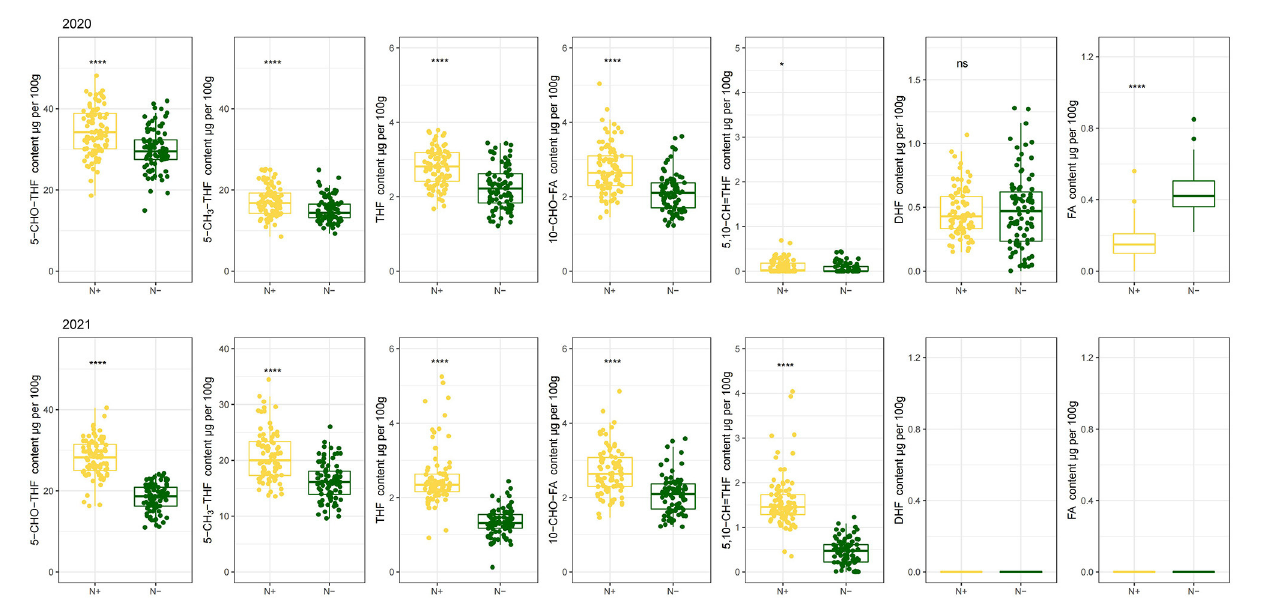
FIGURE3 The distribution of each folate derivative 5–CHO–THF, 5–CH 3 -THF, THF, 10–CHO–FA, 5, 10–CH = THF, DHF and FA grown with or without N fertilization. N–, N deficiency; N + , N applied treatment. *, **** and ns indicate significant differences at 0.05, 0.0001 and no significant difference, respectively.